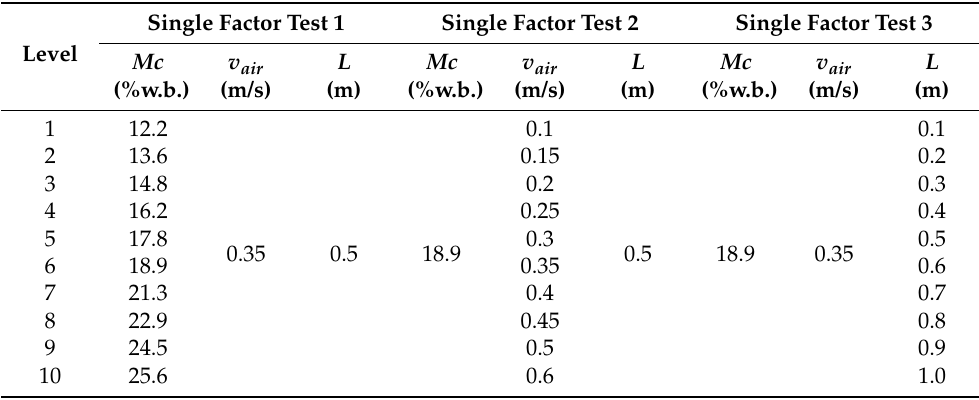
Table 4. Experimental design for the single factor